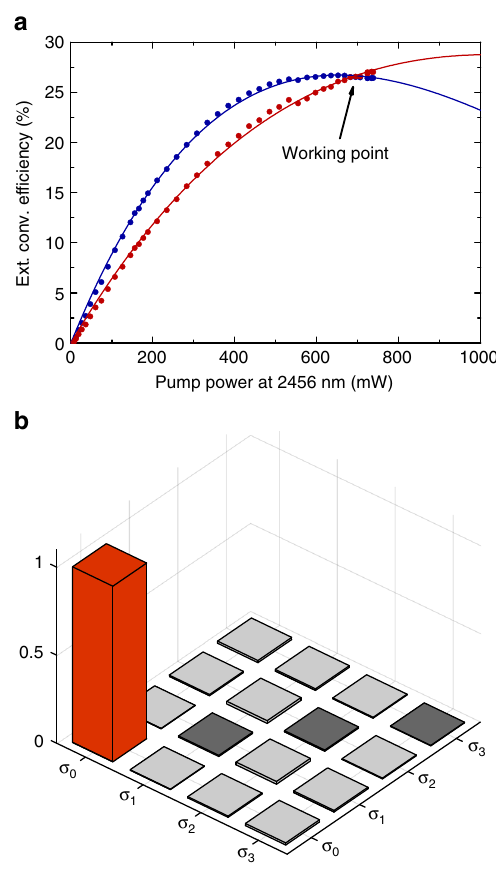
Fig. 3 Characterization of the quantum frequency converter. a The external conversion ef fi ciency of the two interferometer arms depending on the pump power of the mixing fi eld at 2456 nm. The data points are fi tted with (cid:4) (cid:5) ffiffiffiffiffiffiffiffiffiffiffiffiffi p 39 . b The absolute values of the process ð Þ = η η P P η L sin 2 P P ext max nor matrix of the coherent polarization-preserving down-conversion measured with a laser. The process fi delity is determined by the element corresponding to the identity operation (red bar). We achieve a value of 99.75 ± 0.18%. The error bars are deduced from a Poissonian